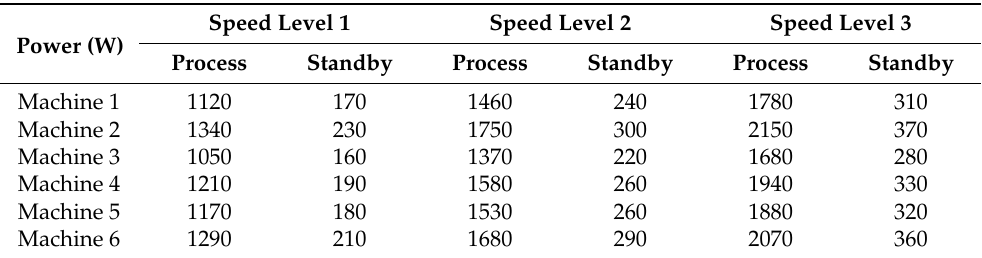
Table 2. Machine process/standby power